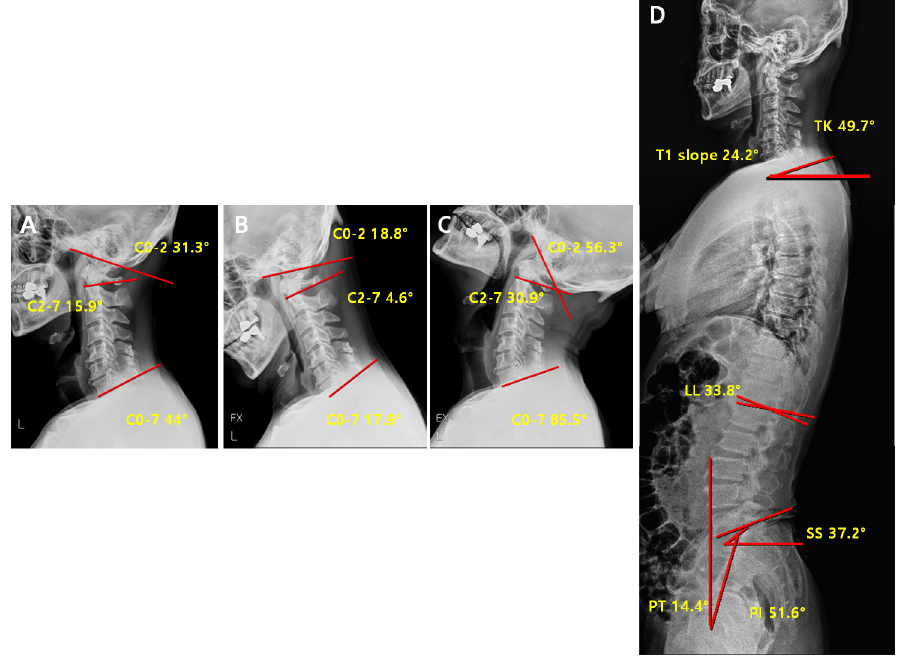
Figure 9. Post-operative radiological parameters in reducible non-lordosis group. Cervical spine lateral X-ray of neutral ( A ), flexion ( B ), extension ( C ) and whole-spine lateral X-ray ( D ).